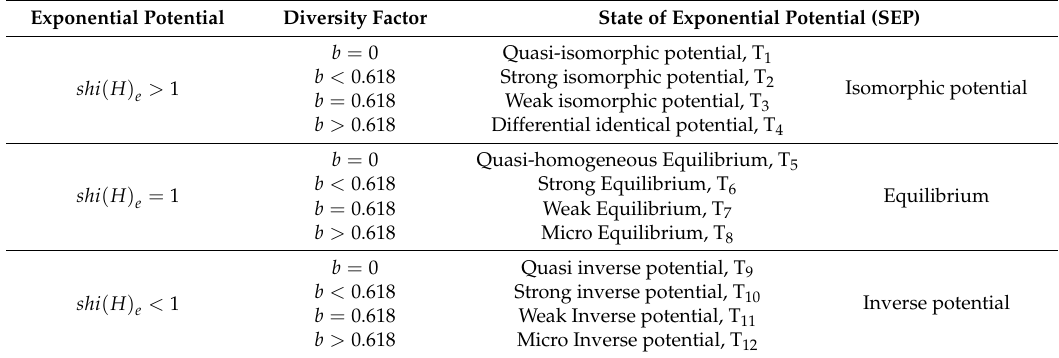
Table 3. The state table of set pair exponential